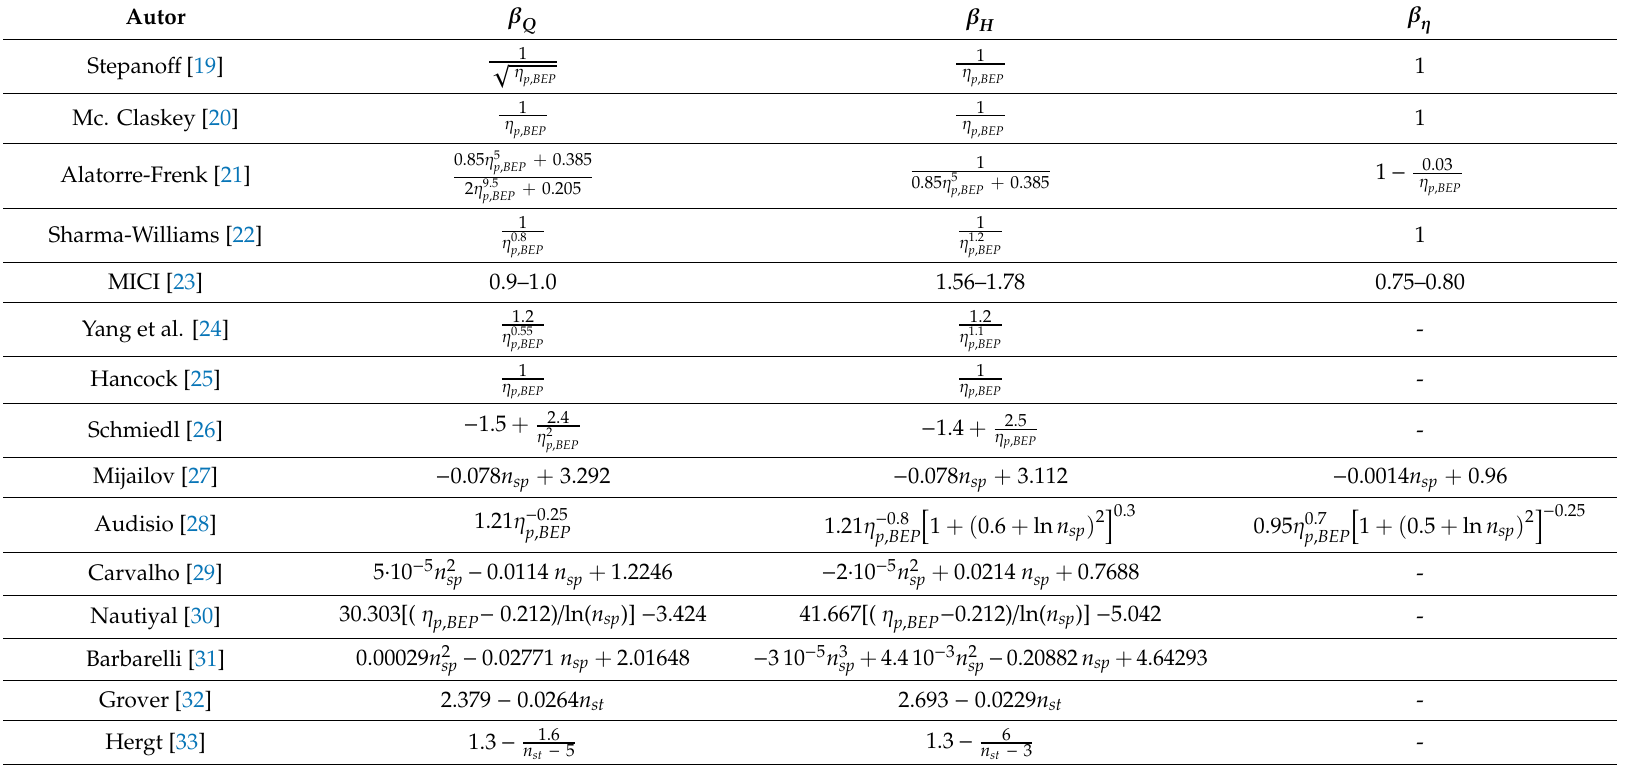
Table 1. Proposed empirical expressions to predict the β coe ffi